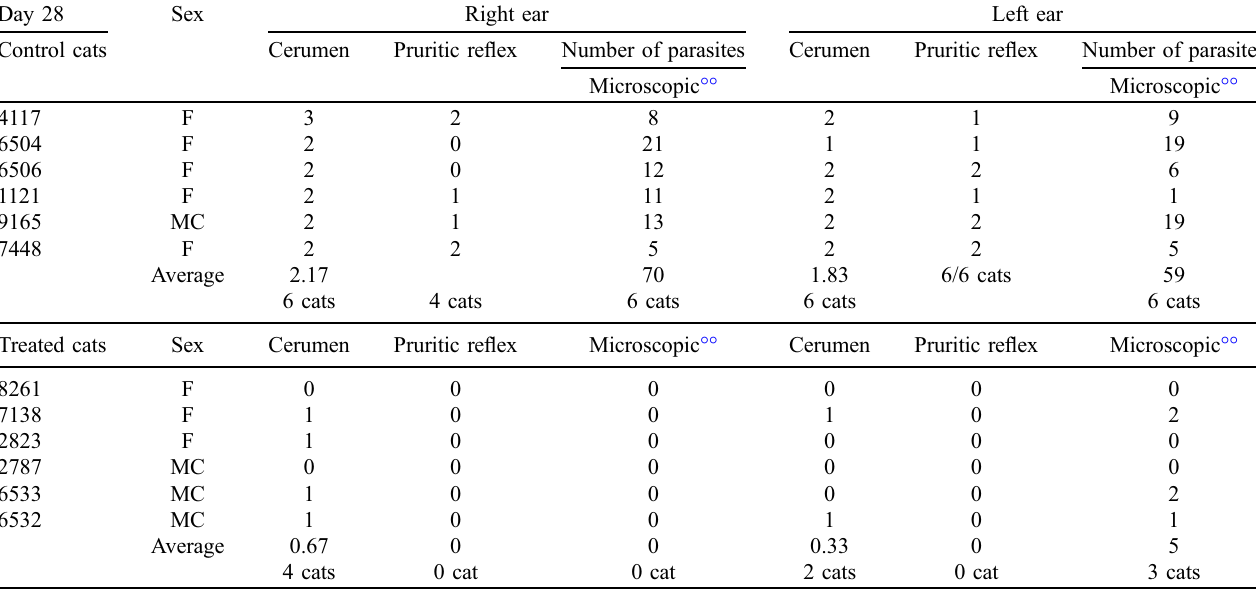
Table 4. Comparison of control and treated cats at Day